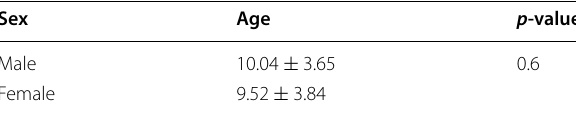
Table 1 Mean and standard deviation of age by gender